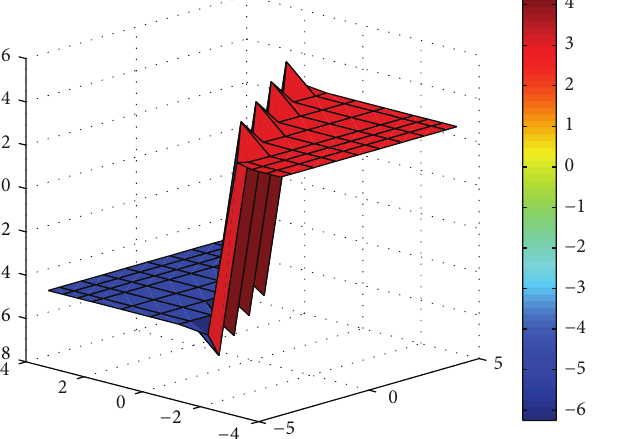
Figure6:Thesolitarywaveandbehaviorofthesolutions 𝑢(𝑥, 𝑦,𝑡) = −1 + 2 tanh (𝑥 − 2𝑦 + 𝑡) + 2 tanh −1 (𝑥 − 2𝑦 + 𝑡) for 𝑡 = 0 , −4 ⩽ 𝑥 ⩽ 4 , and −4 ⩽ 𝑦 ⩽ 4 .